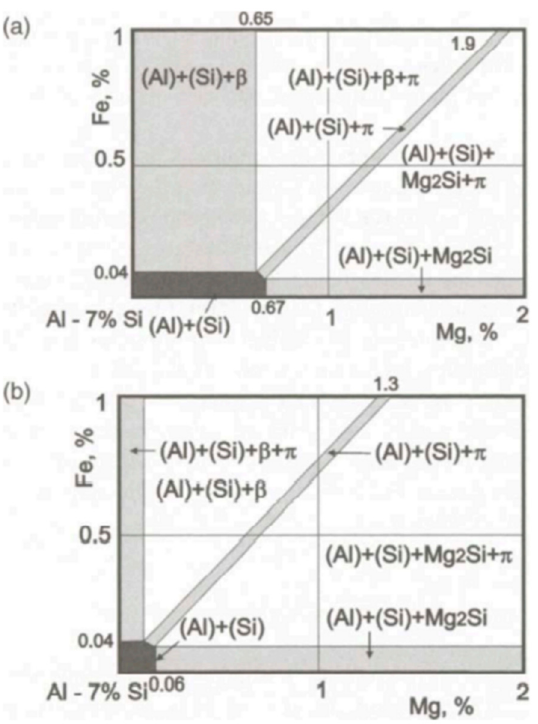
Figure 4. Isothermal sections of Al-Fe-Mg-Si phase diagram at 7% Si: ( a ) 540 °C and ( b ) 200 °C; β -Al 5 FeSi, and π -Al 8 FeMg 3 Si 6 [27].